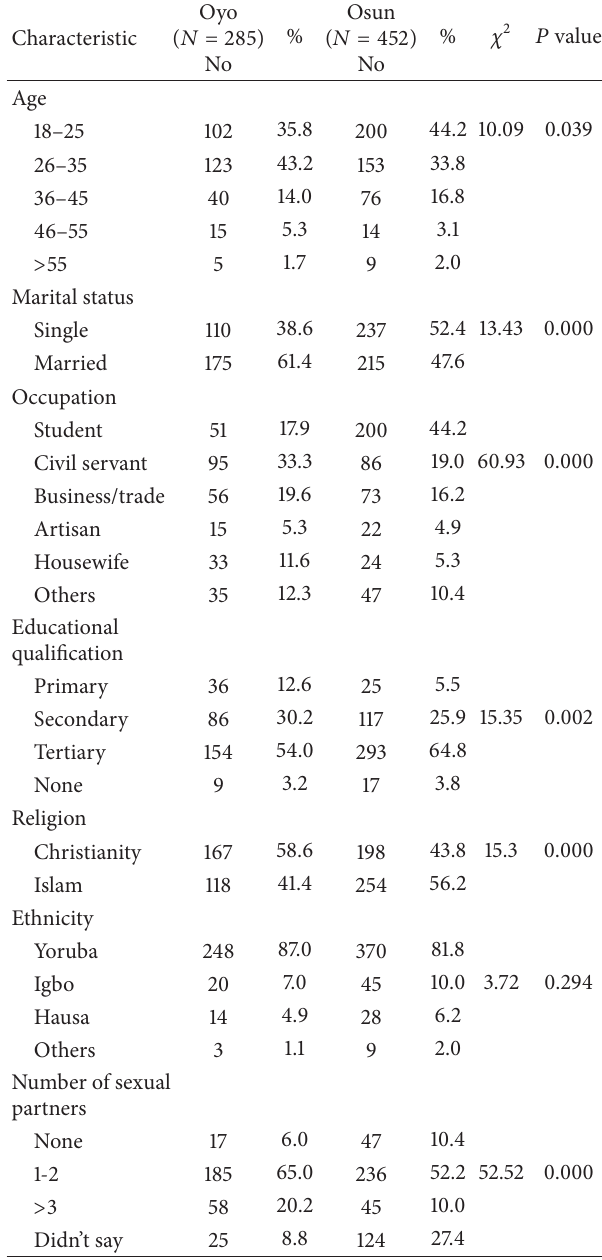
Table 1: Demographic